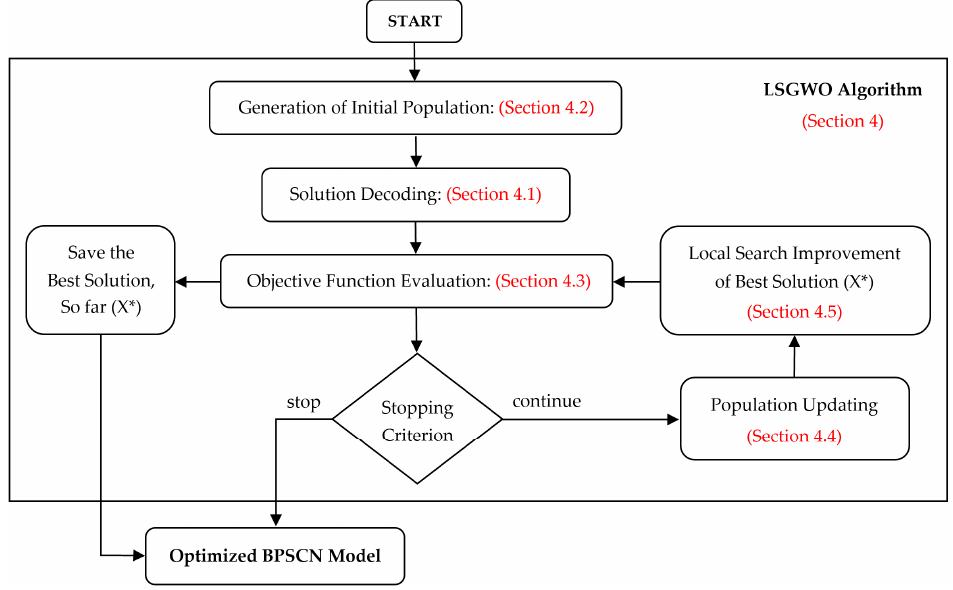
Figure 2. Flowchart of the LSGWO algorithm for solving the BPSCN model. Algorithm 1. Local Search empowered Grey Wolf Optimizer (LSGWO)